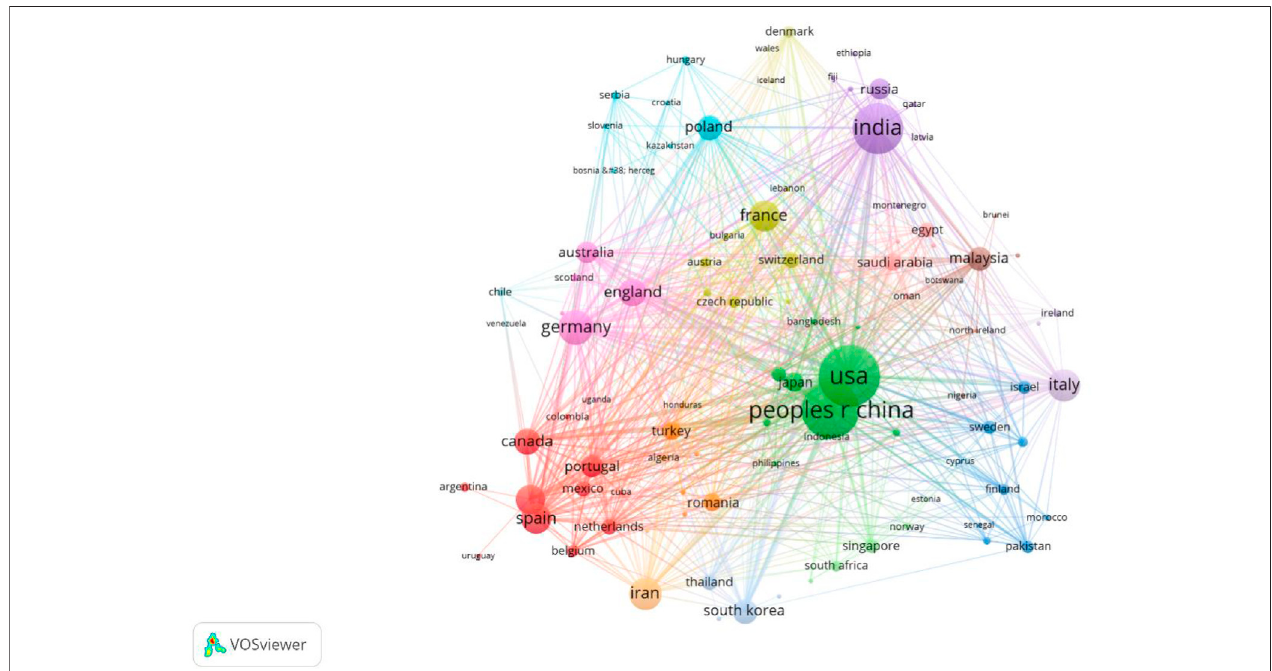
FIGURE 3 | Country/region cooperation knowledge graph (frequency ≥